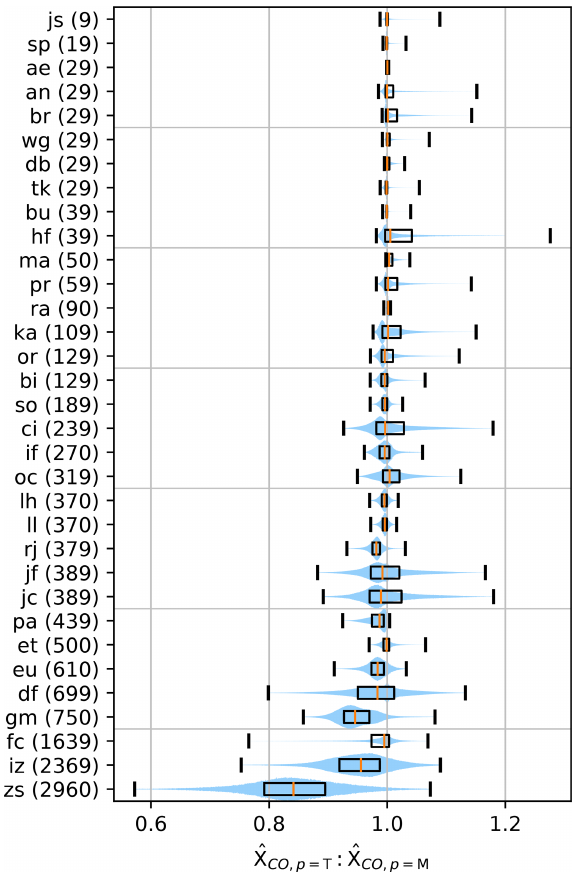
Figure 4. Scaling factors for MOPITT retrieved profiles if the sur- face were at the surface of the TCCON site (listed in ma.s.l. in parenthesis). Ordered by increasing site altitude. Soundings within ± 5 ◦ latitude and ± 5 ◦ longitude of TCCON site are used. The center 99% of data are shown. Blue filled sections indicate data density, similar to a violin plot but using histograms rather than a kernel density estimation due to sufficient data. Black boxes indicate the central 50% of data, and medians are orange.